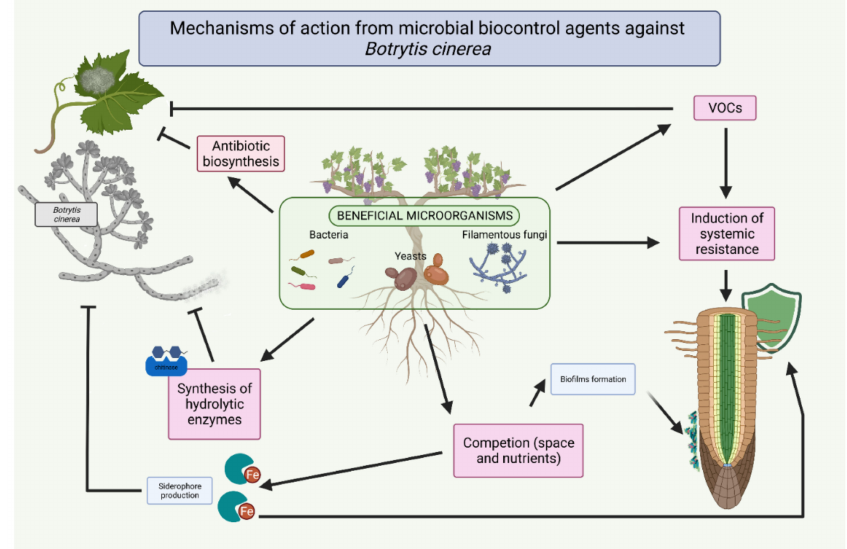
Figure 1. Mechanisms of action from microbial biocontrol agents against Botrytis cinerea